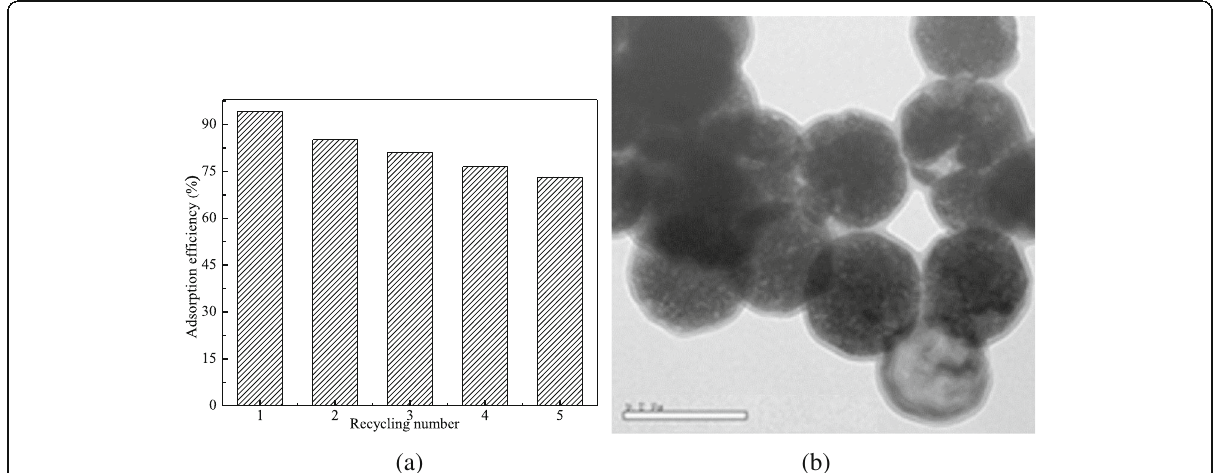
Fig. 7 The reuse frequencies of the MCMs and its morphology after reused four times. a The reuse frequency. b The morphology of the MCMs after reused four